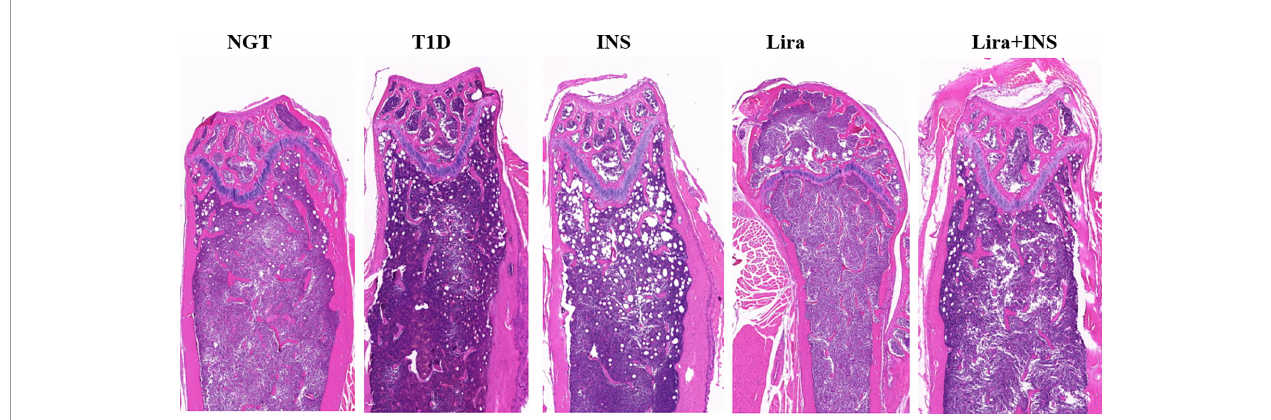
FIGURE 4 | Typical H&E images of bone histomorphometry. NGT, normal glucose tolerance group; T1D, type 1 diabetes group; INS, insulin treatment group; Lira, liraglutide treatment group; INS+Lira, insulin + liraglutide